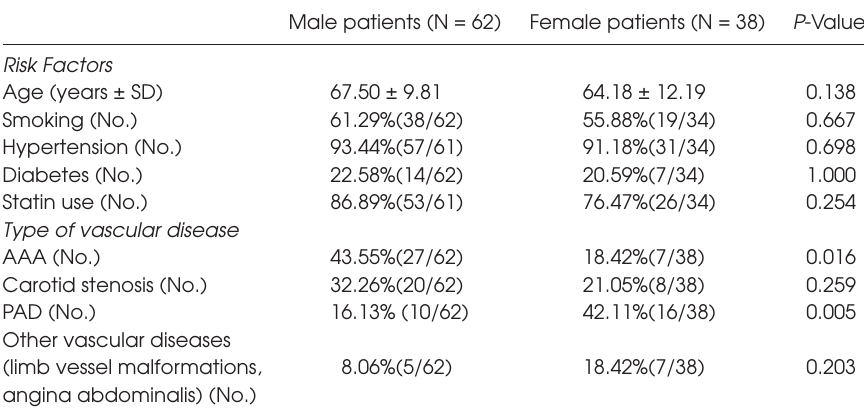
Table 1A. Patient characteristics according to sex.